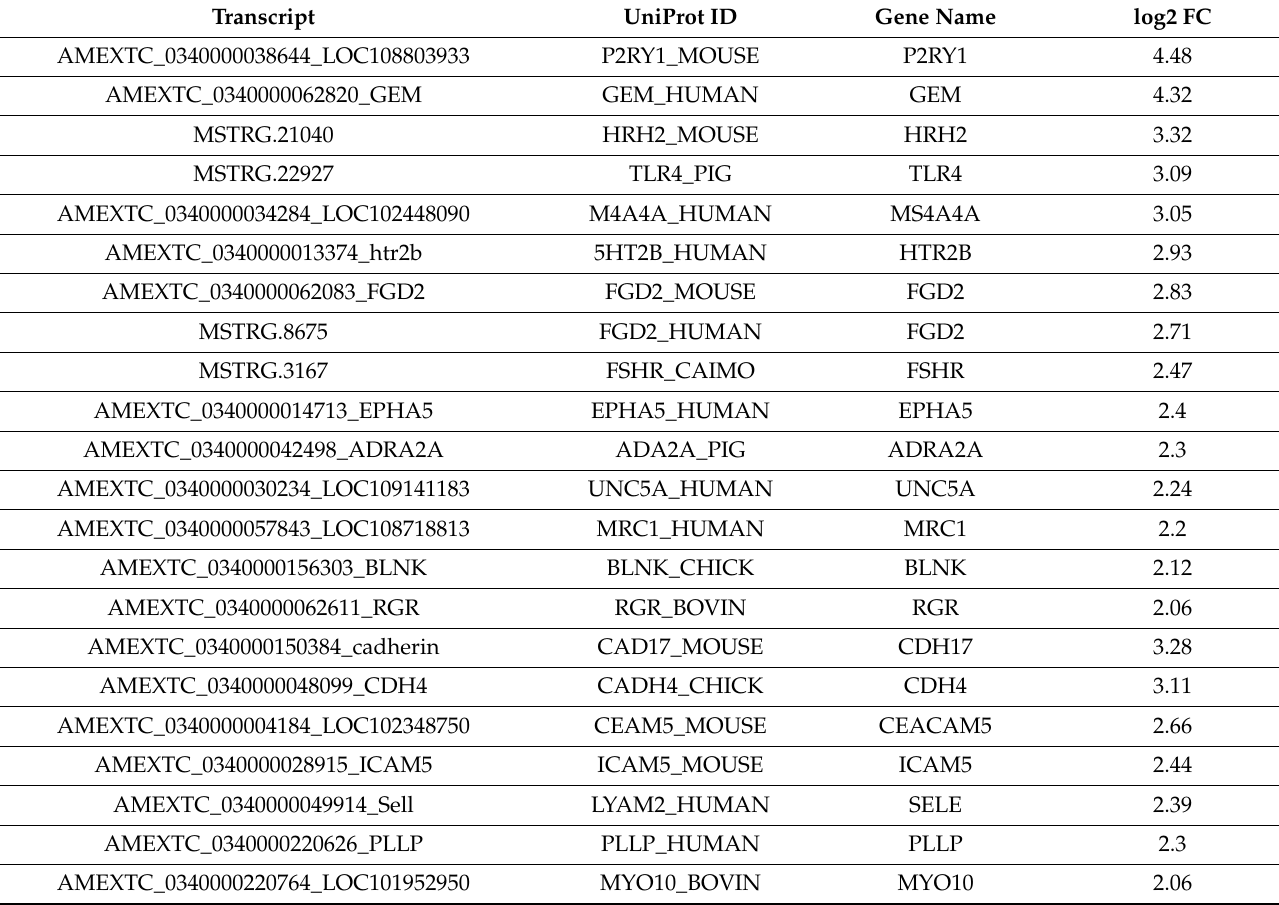
Table 3. Genes encoding membrane-bound proteins. The transcript name is given as “AMEXTC” if the transcript is found in the reference genome or “MSTRG” if identified as novel by StringTie. The UniProt ID and gene name are given for the most similar homolog as determined by BLASTx search. The log2 fold change was determined by edgeR, with positive values indicating upregulated expression following Am580